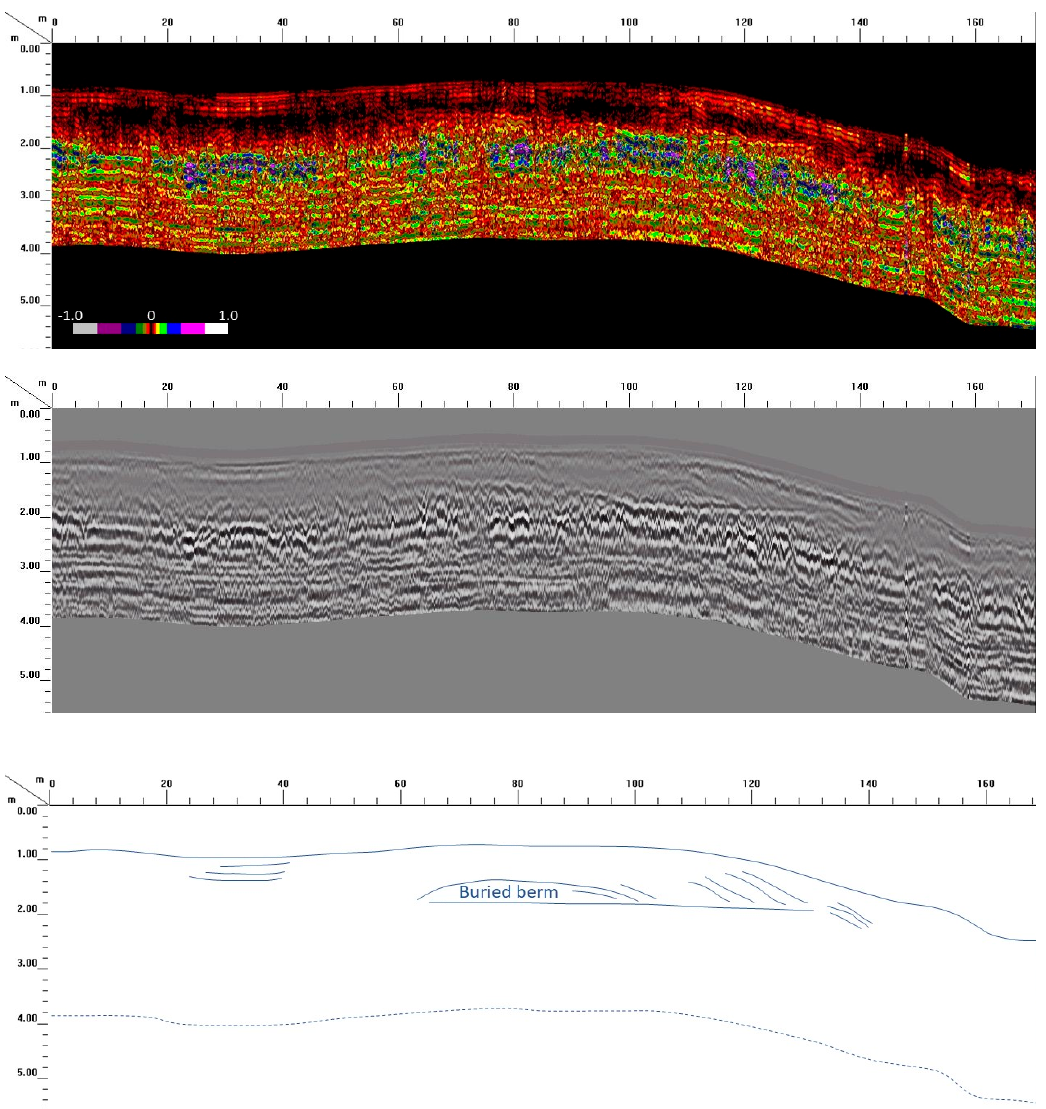
Figure 12. GPR profile and interpretation for the 1718 m shoreline. In the upper transect, data are presented with a color scale to highlight the normalized intensity of radar reflectors. The lower profile presents the same data in grayscale. In both profiles, landward is to the left and lakeward is to the right. Vertical exaggeration 9×.